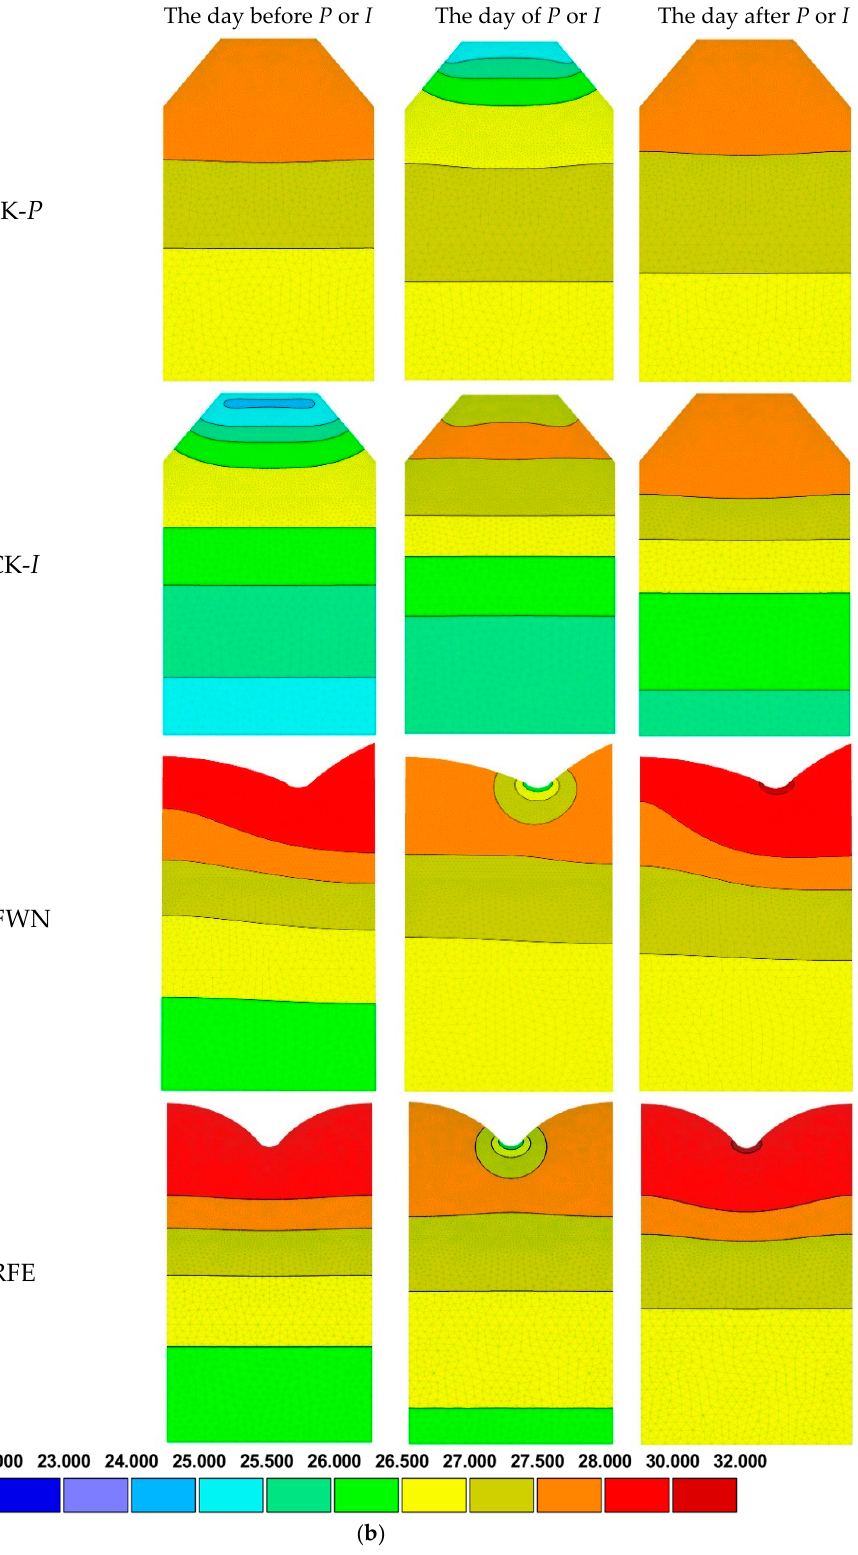
Figure 5. Two-dimensional distribution of soil water and heat. ( a ) Two-dimensional distribution of soil water during a rainfall or irrigation; ( b ) Two-dimensional distribution of soil temperature during a rainfall or irrigation; P represents rainfall event and I represents irrigation event.